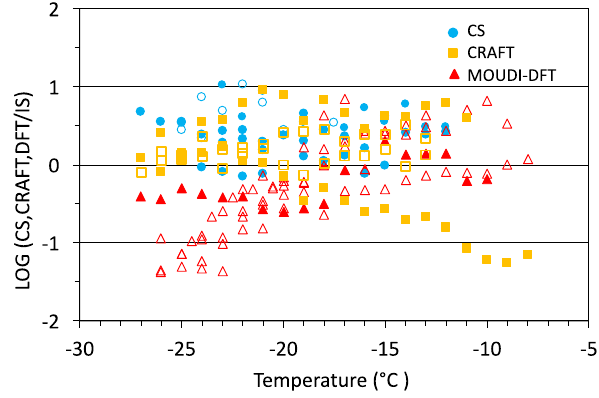
Figure 5. Immersion freezing methods comparison, shown as the base 10 logarithm of the ratio of the CS, CRAFT and MOUDI-DFT method INP concentrations for perfect or imperfect overlap of co- sampling periods with the IS INP number concentrations. Samples collected outside the CSU atmospheric chemistry facility are shown as filled symbols, while samples collected at other sites on differ- ent days (CS: Bodega Bay; CRAFT: Canyonlands Research Center; DFT: Colby, KS) are shown as open